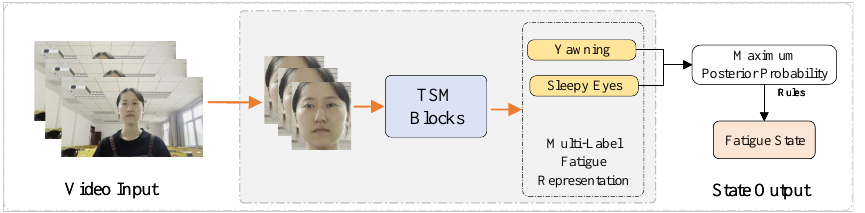
Figure 1. Architecture of the interpretable student fatigue monitoring network. The proposed network includes an anomaly classification module and a Bayesian fatigue state inference